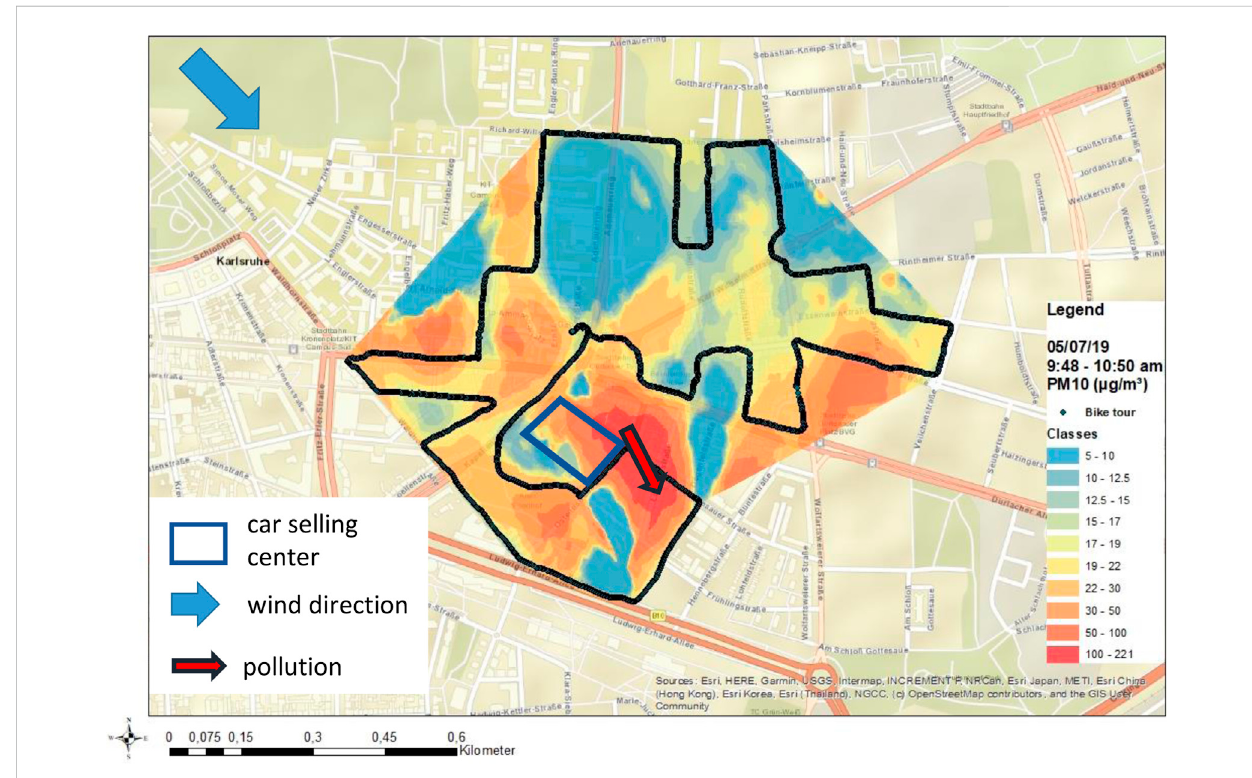
Interaction of wind direction and aerosol distribution pattern on 5th of